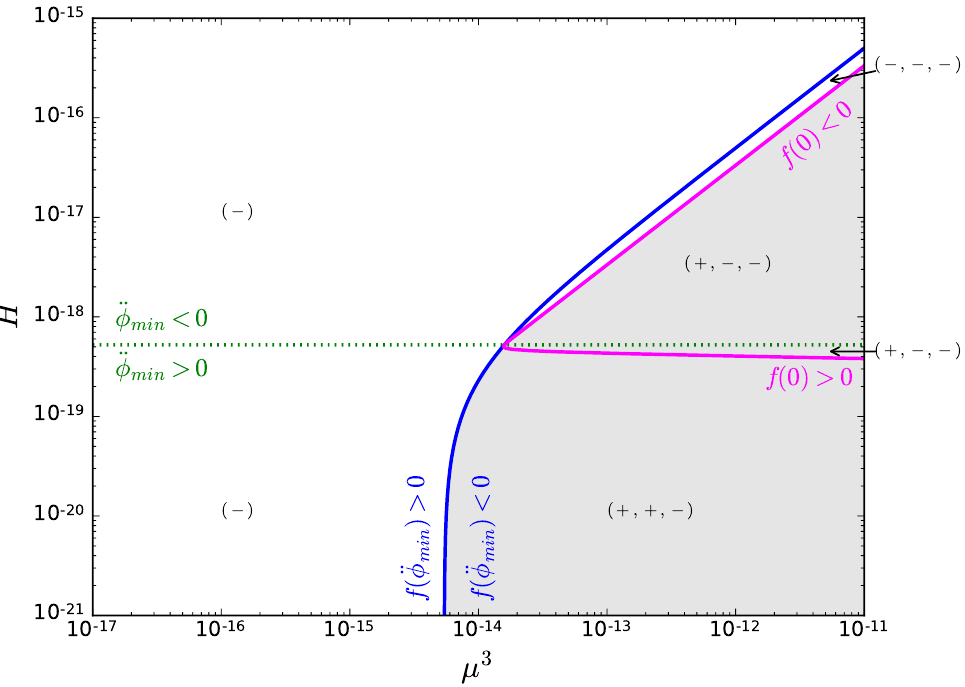
Figure 20 . The solutions of eq. (3.15) are classi(cid:12)ed in the (cid:22) 3 - H plane. We take _ (cid:30) = 10 4 , f = 10 5 in units of (cid:3) b = 1. (cid:127) (cid:30) min < 0 ((cid:127) (cid:30) min > 0) is satis(cid:12)ed above (below) the green line. f ( _ (cid:30); (cid:127) (cid:30) min ) < 0